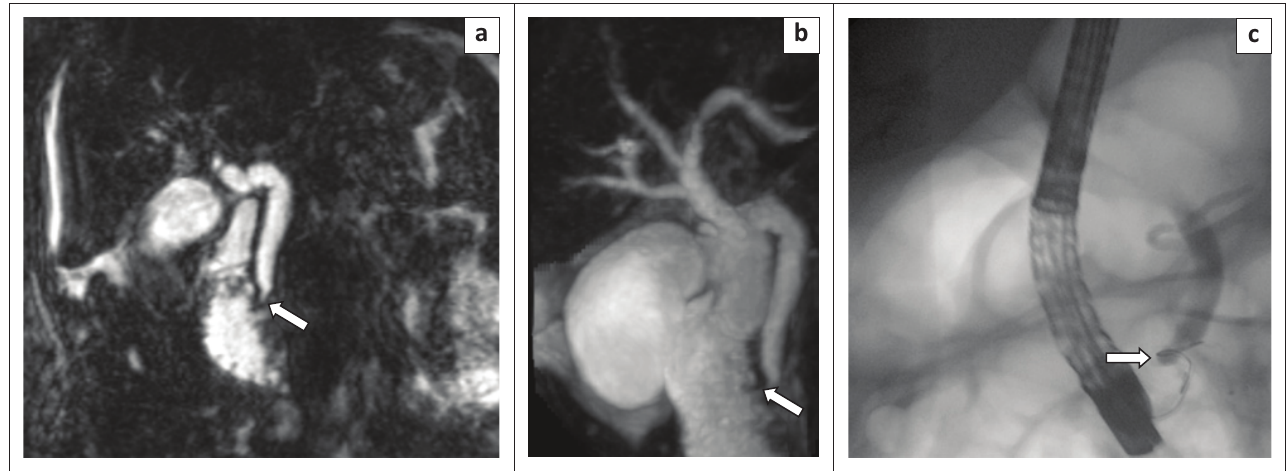
FIGURE 3: Eighty-seven-year-old woman with a benign stricture (white arrow) which was demonstrated by MRCP (a), 3D reformatted image from MRCP (b), and ERCP (c).